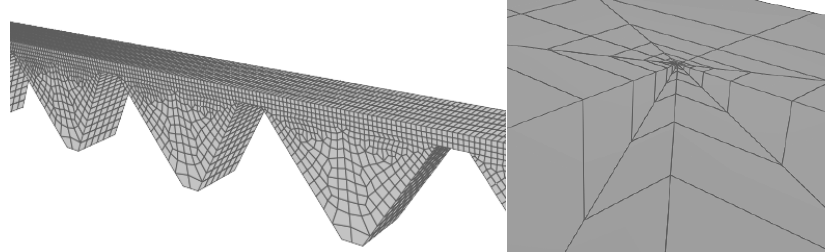
Fig. 2. Sample mesh and refined part of the mesh (meshing of the photothermal impact area).